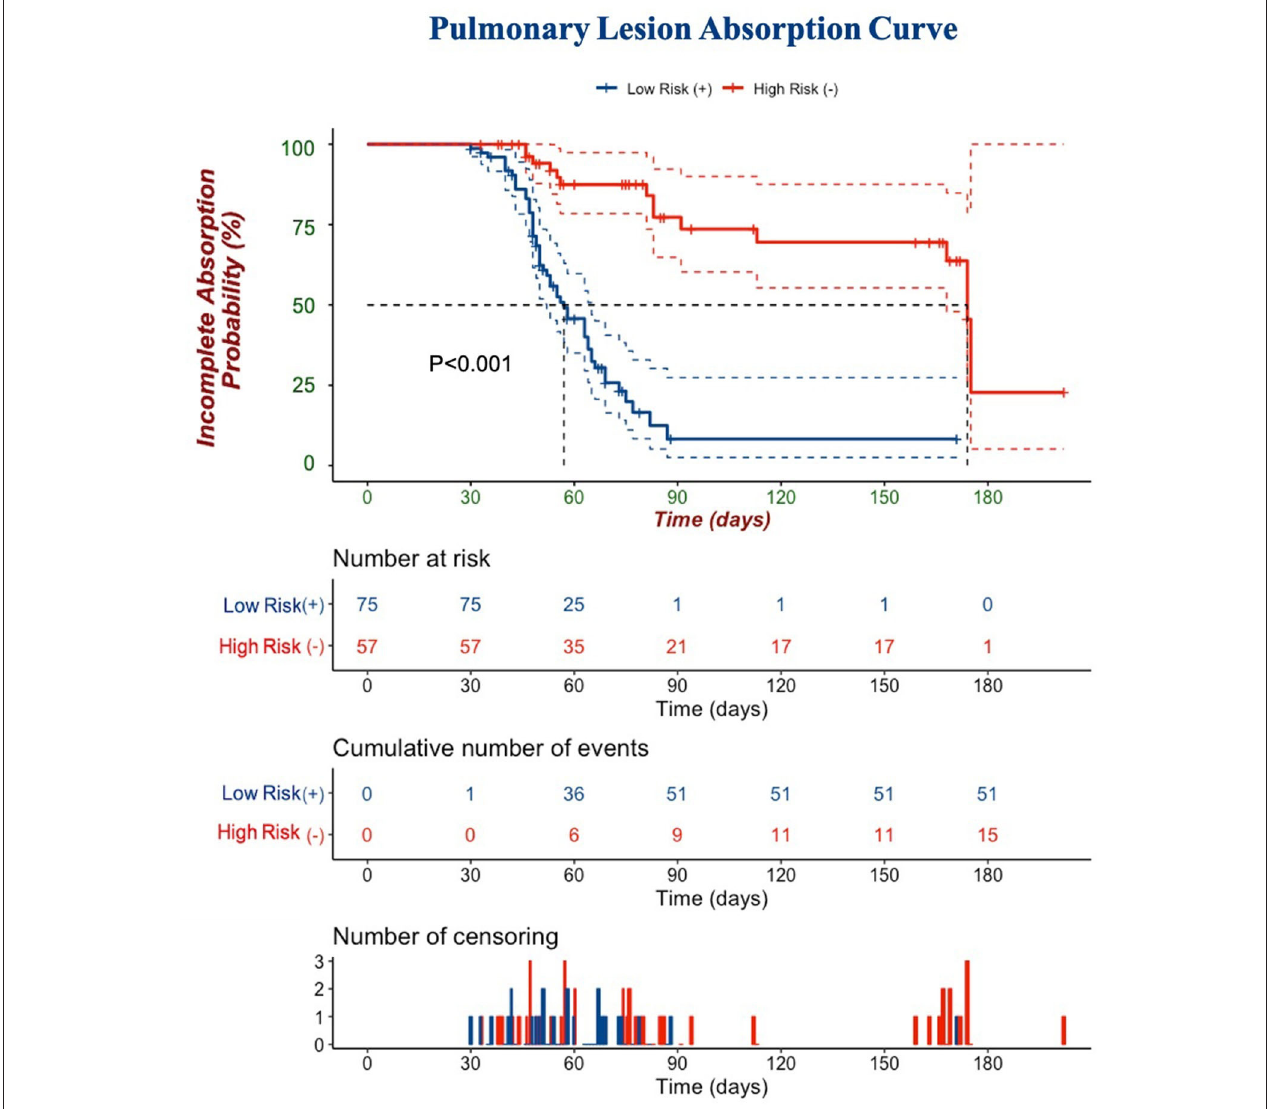
FIGURE 4 | A Kaplan–Meier curve is depicted to demonstrate the ability of Cox regression to discriminate complete and incomplete pulmonary absorption in patients. Cumulative number of events: cumulative number of patients who had pulmonary lesions completely absorbed. The number of censorings: the number of patients who had pulmonary lesions completely absorbed or lost follow-ups before the end of our